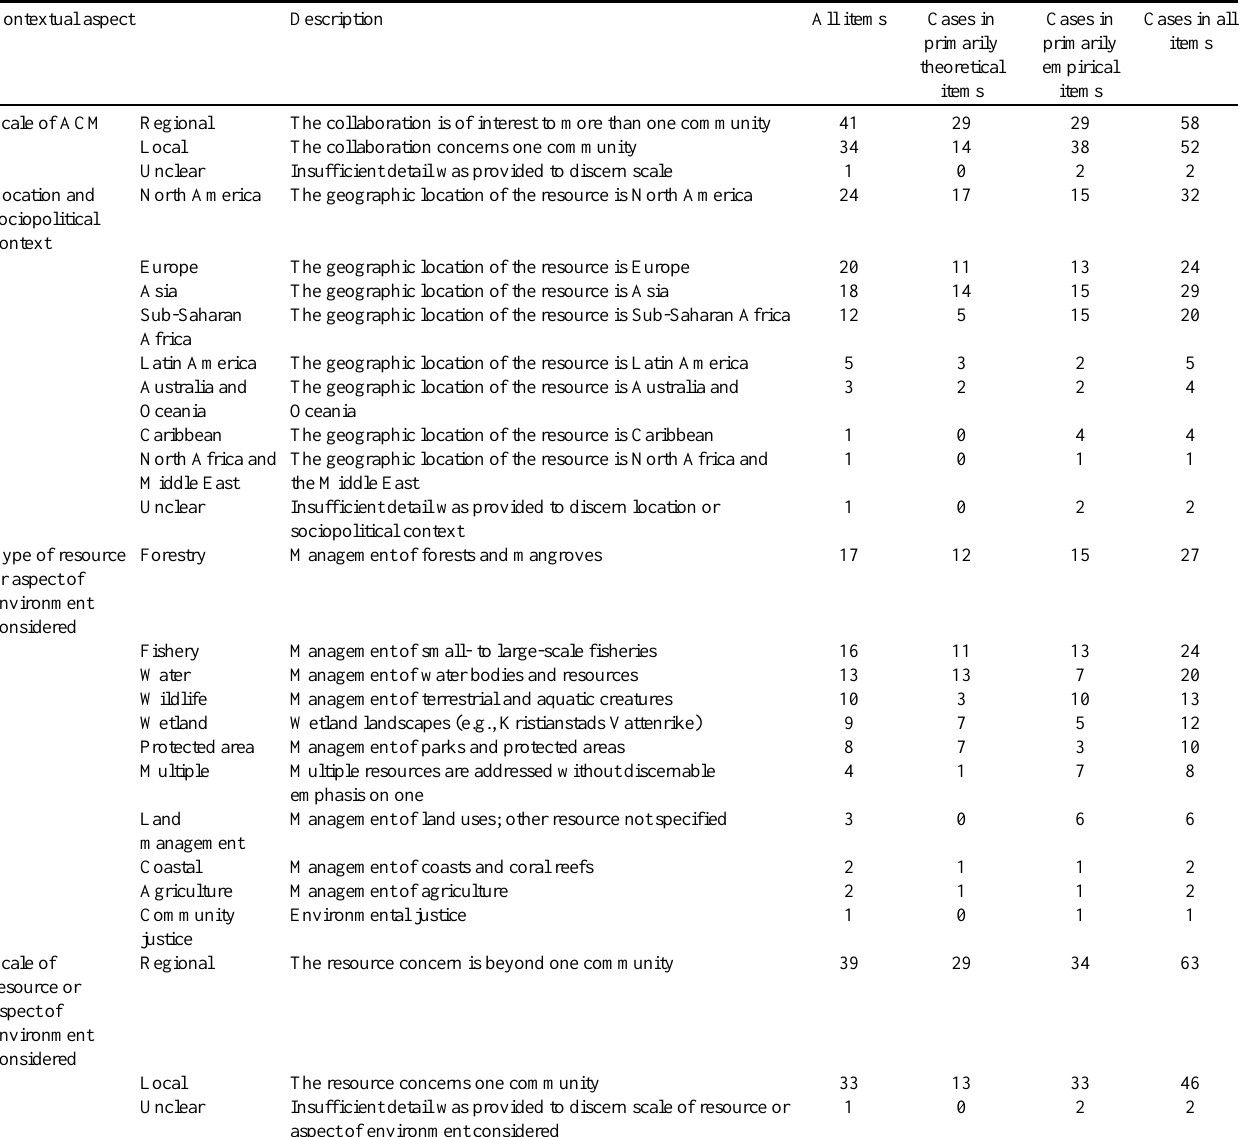
Table 1. Contextual aspects of the adaptive comanagement